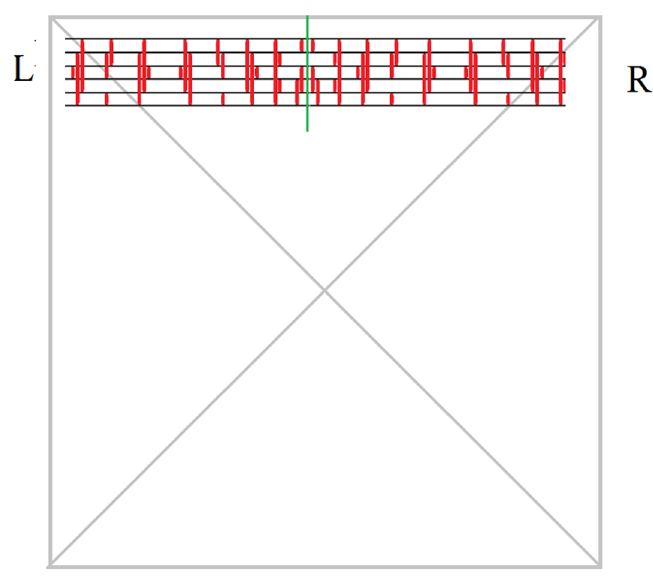
Figure 2 . Quantum circuiti in (cid:12)gure 1 becomes the tensor network representing ERB at time t . Figure 16: The quantum circuit in figure 15 can be lifted up to the maximal slice where it defines a tensor network description of the ERB. matrix (cid:26) A . If we write (cid:26) A in Schmidt basis, it’s easy to see that the unitary operations that do not change (cid:26) A are the relative rotations of the Schmidt basis. They can be undone from subsystem B. These operations only make sense when we have both subsystems A and B. They do not belong to either subsystem alone as they do not change the density matrix of A or